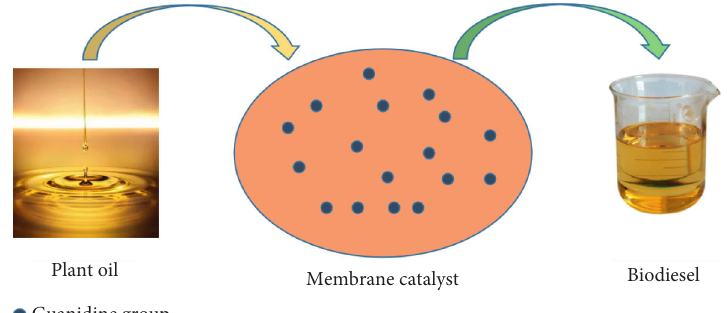
Figure 9: The chitosan-based membrane catalyst. Reproduced with permission from [53] copyright 2015,